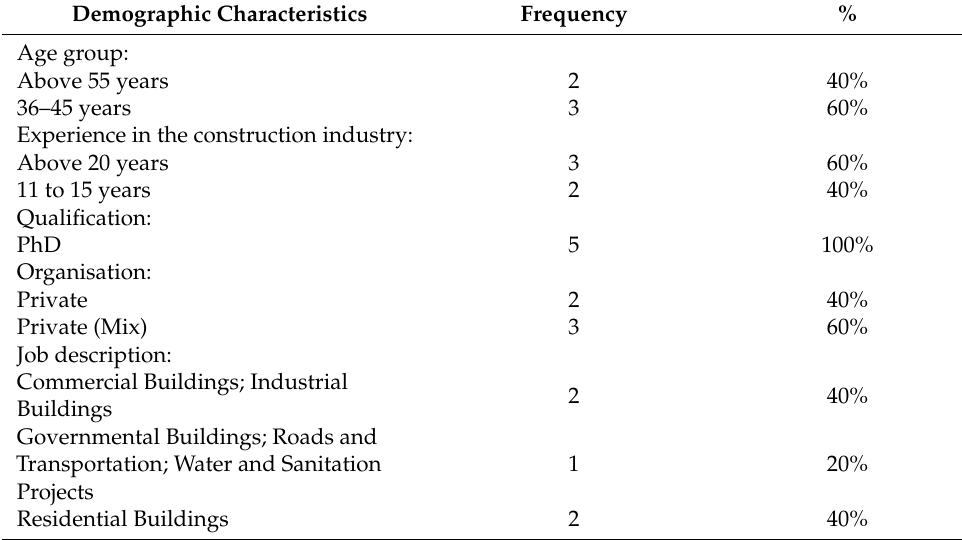
Table 3. Demographic characteristic analysis for the